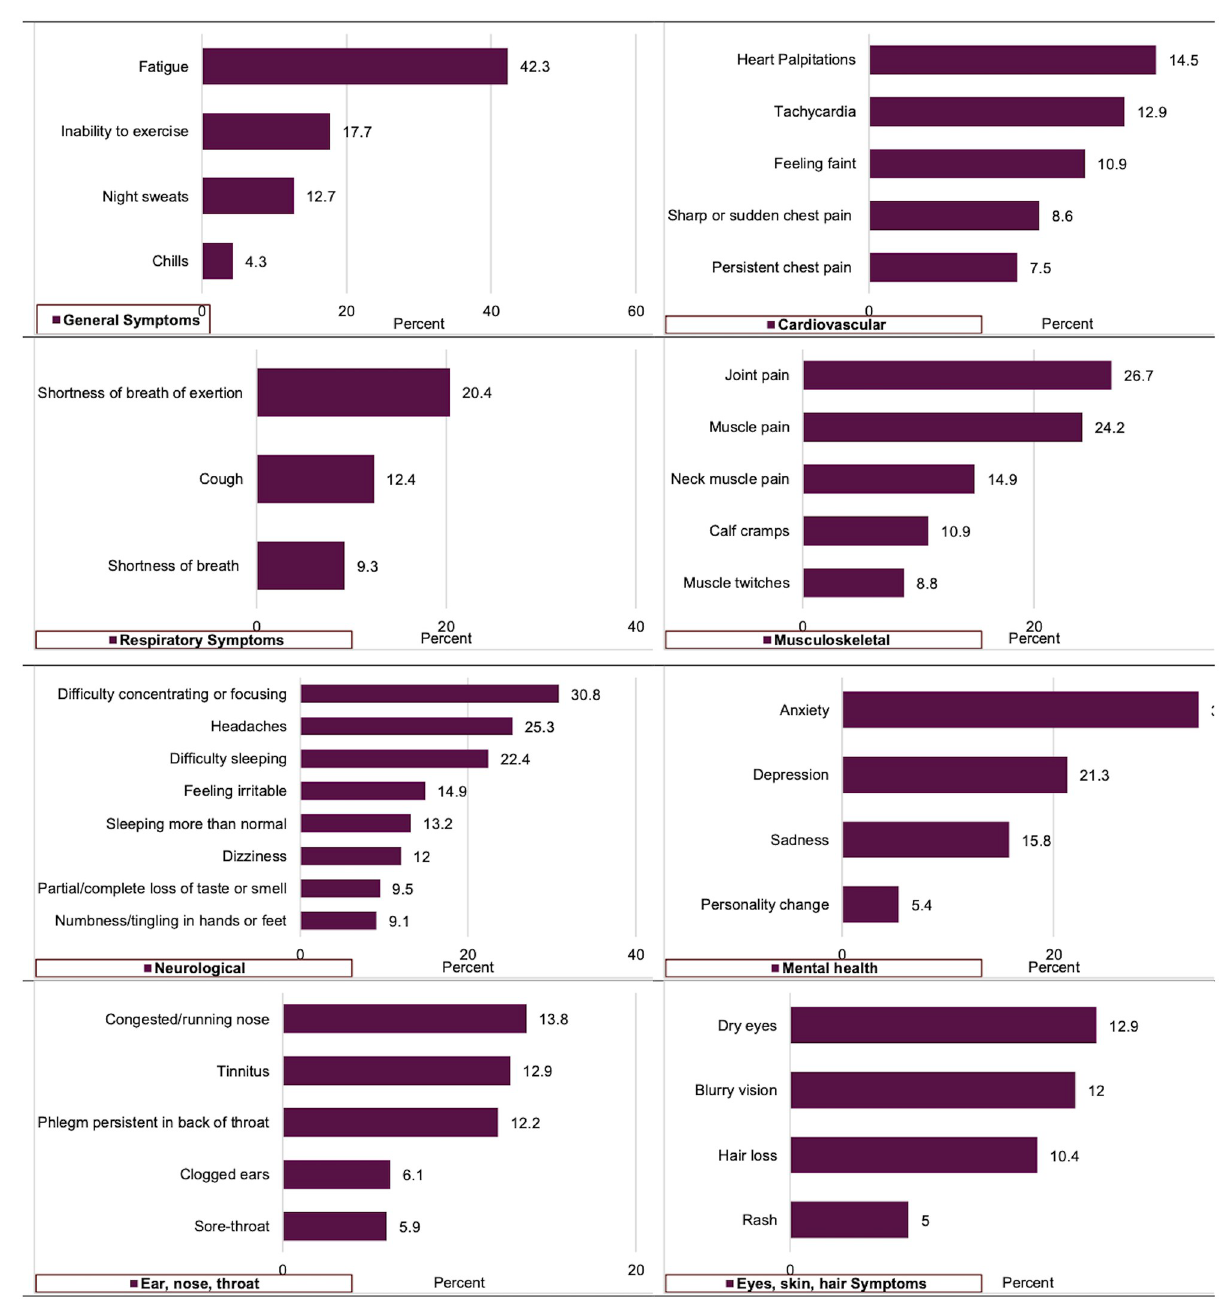
Fig 1. Reported Post-Acute Sequelae of SARS-CoV-2 Infection (PASC) symptoms (N = 442).